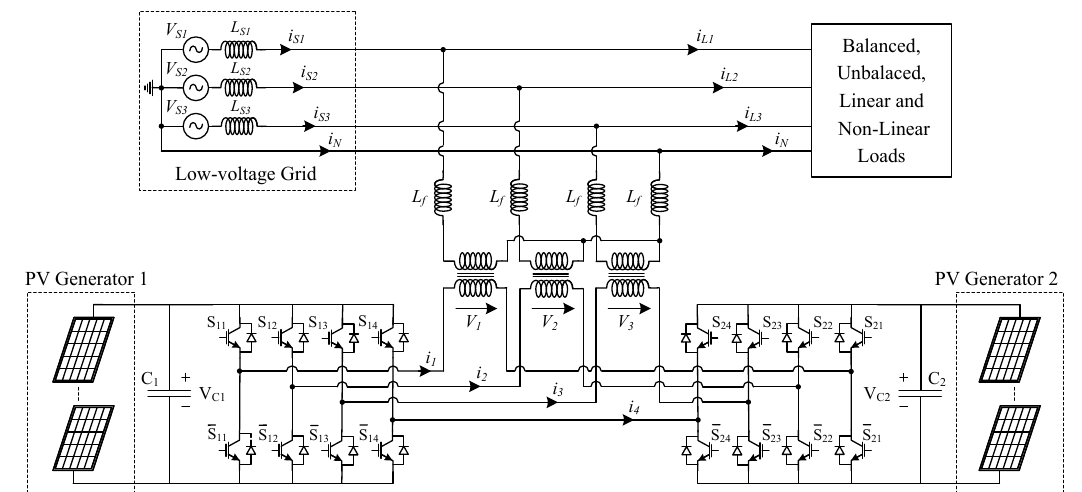
Figure 2. Proposed structure for grid-connected PV systems based on two four-leg VSIs.